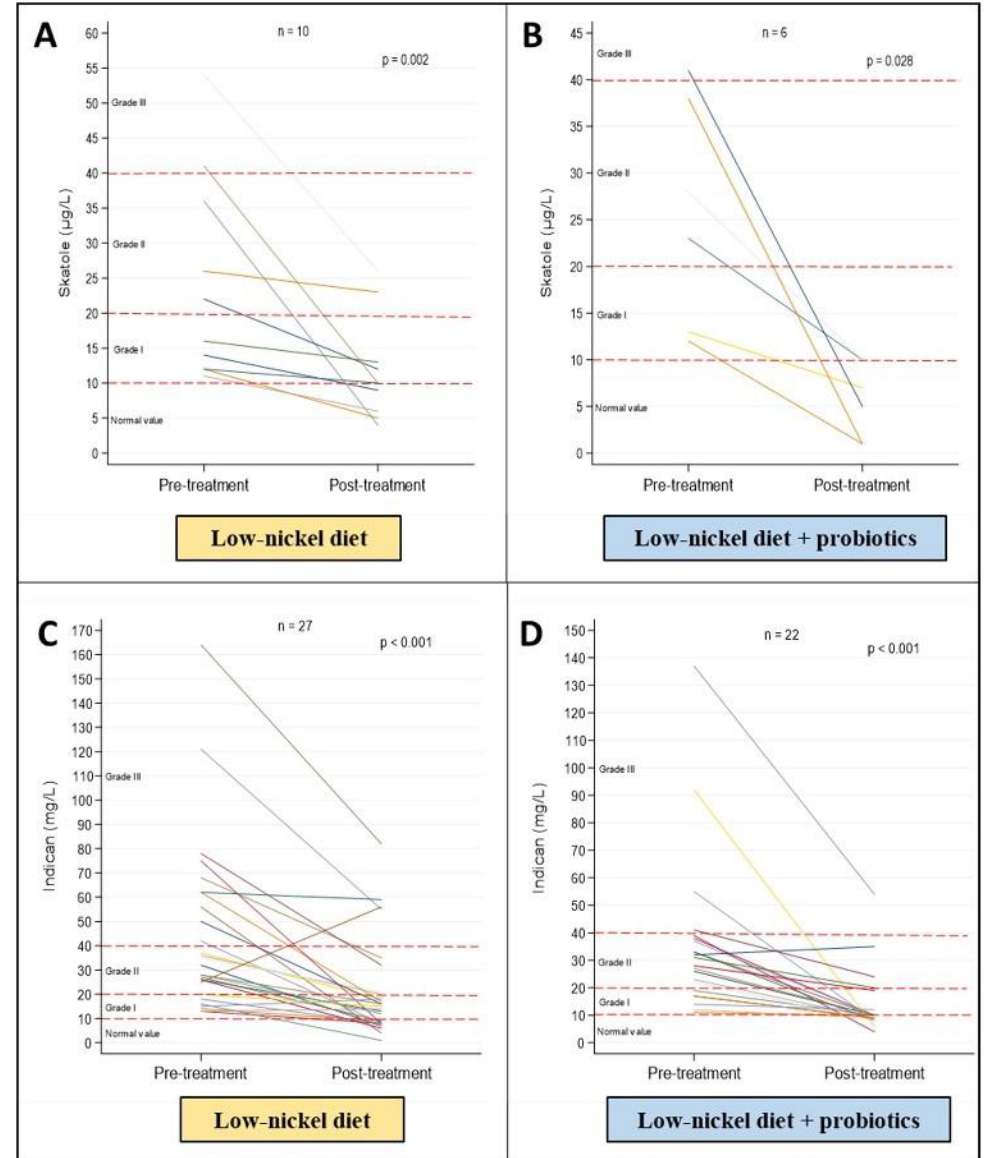
Figure 5. Representation of pre- and post-treatment concentrations of skatole (µg/L) and indican (mg/L) in patients with pre-treatment abnormal values by spaghetti plots. ( A ) Pre- and post-treatment levels of skatole in patients who followed the low-Ni diet alone. ( B ) Pre- and post-treatment levels of skatole in patients who followed the low-Ni diet combined with probiotics. ( C ) Pre- and post-treatment levels of indican in patients who followed the low-Ni diet alone. ( D ) Pre- and post-treatment levels of indican in patients who followed the low-Ni diet combined with probiotics.